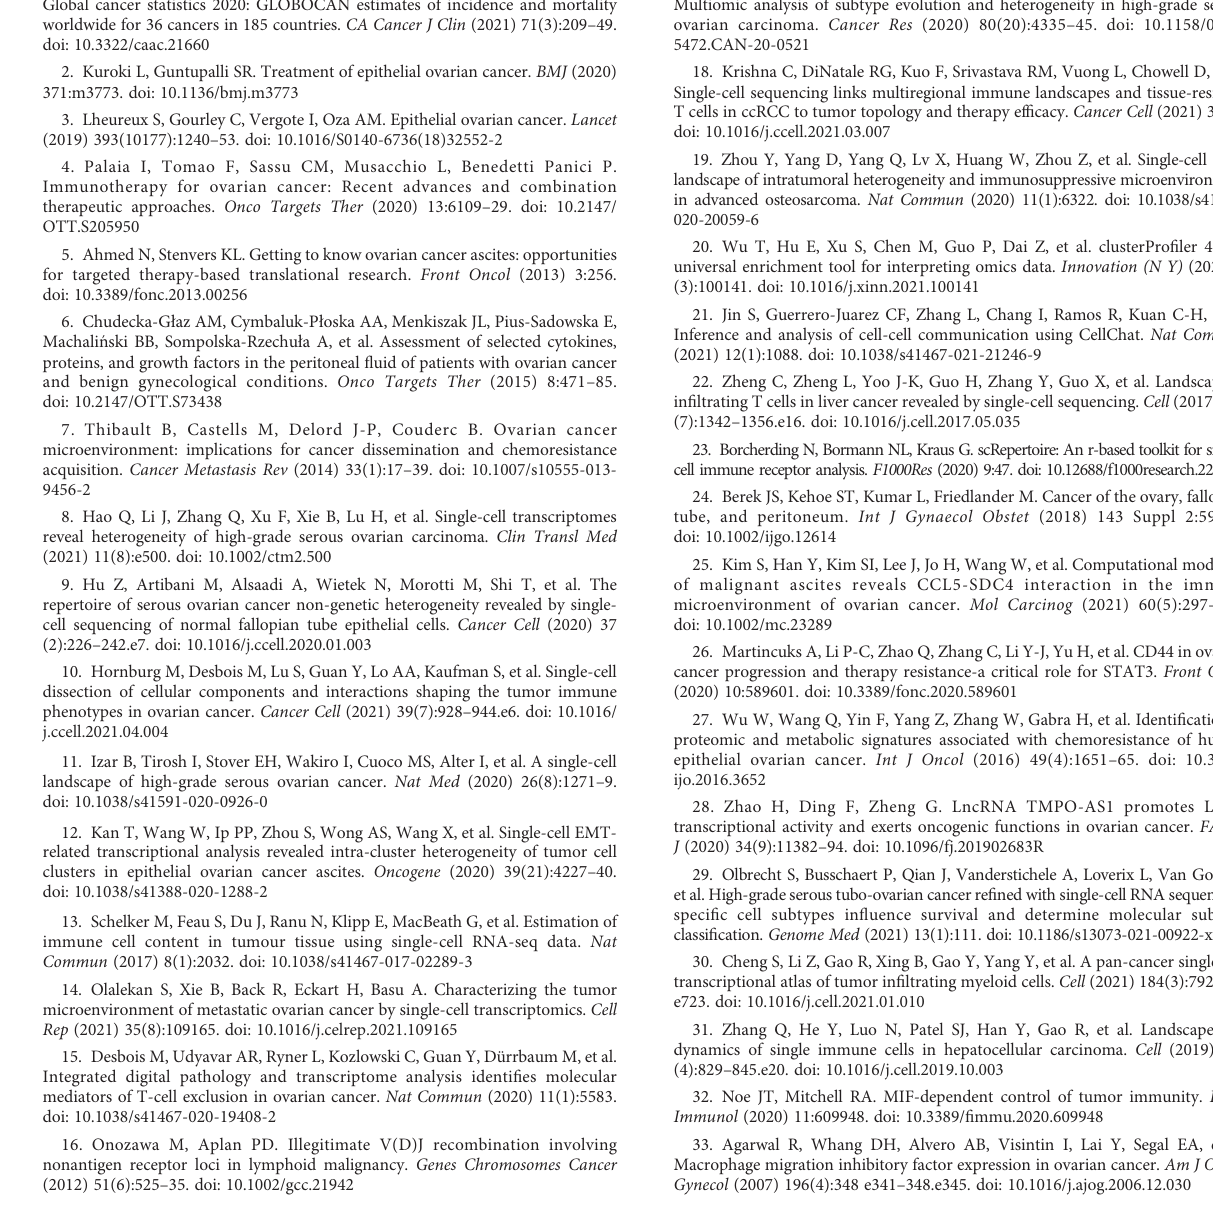
changes are labeled red. (*indicates a FDR < 0.01, ** indicates a FDR < 0.001, *** indicates a FDR < 0.0001, **** indicates a FDR < 0.00001). The results above are generated by comparison between samples ( blood_before, blood_after ). SUPPLEMENTARY FIGURE S8 Comparative analysis of BCRs in naïve and memoryB cells across samples pre and post chemotherapy. (A) Curve graphs show CDR3 aa length distribution of IGL (upper right), IGH (bottom right) and both (left) of all BCRs across samples pre and post chemotherapy. (B) Violin plots show the CDR3 aa length distribution of IGH chains plus IGL chain. (C)